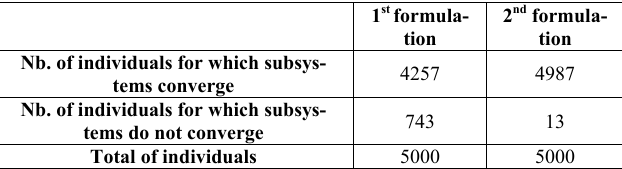
Table 6. Summary of formulations